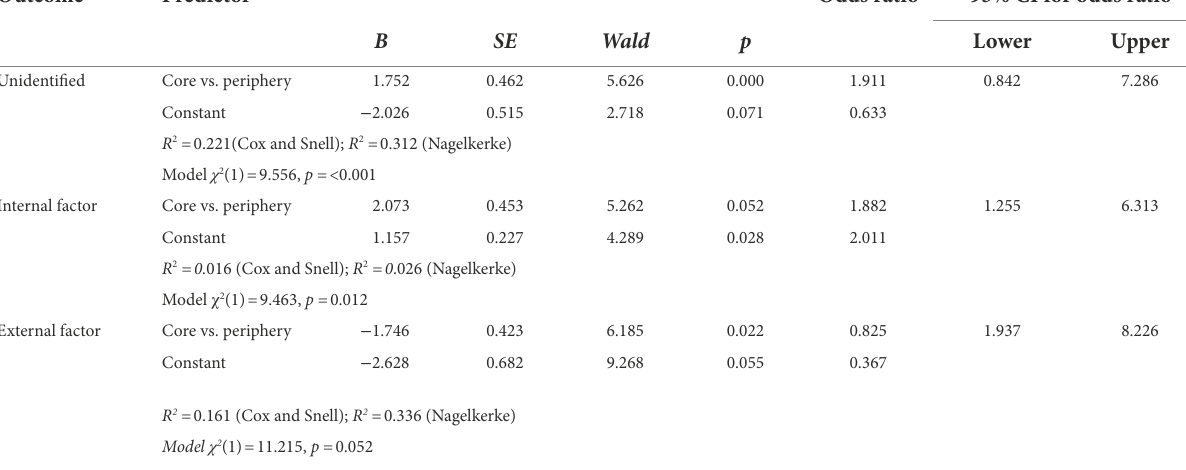
TABLE 5 Results of binary logistic regressions on the frame element of explanation. Outcome Predictor